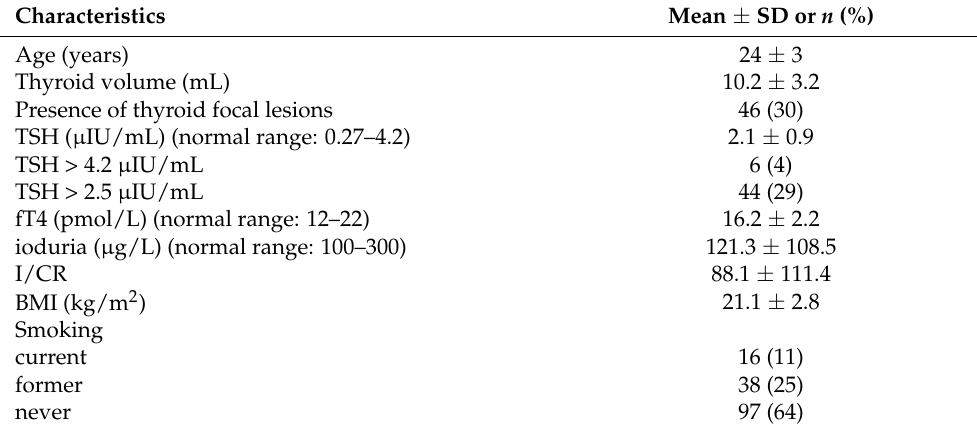
Table 1. Characteristics of the study population ( n = 151).